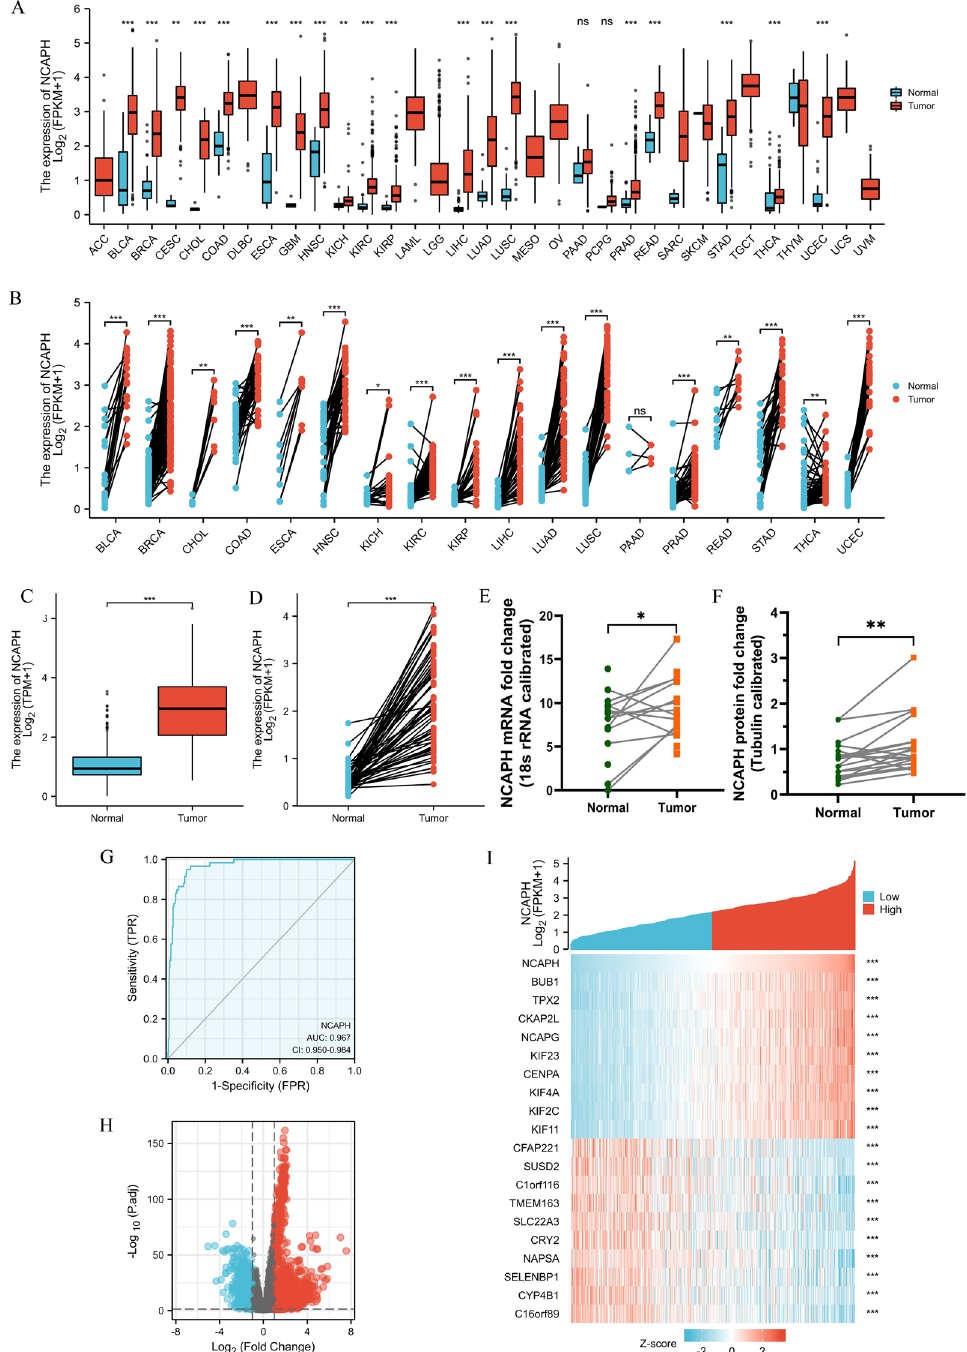
Figure 1. Expressions of NCAPH in tumors and NCAPH-related DEGs. ( A ), ( B ) Abnormal expression of NCAPH in cancers in TCGA. ( C ), ( D ) Levels of NCAPH in LUAD. ( E ), ( F ) The mRNA and protein expression of NCAPH in 20 LUAD samples and matched normal samples. ( G ) ROC curve to test the value of NCAPH to identify LUAD tissues. ( H ), ( I ) Volcano plots of the DEGs and heat map showing the top 20 DEGs. * P < 0.05, ** P < 0.01, *** P <